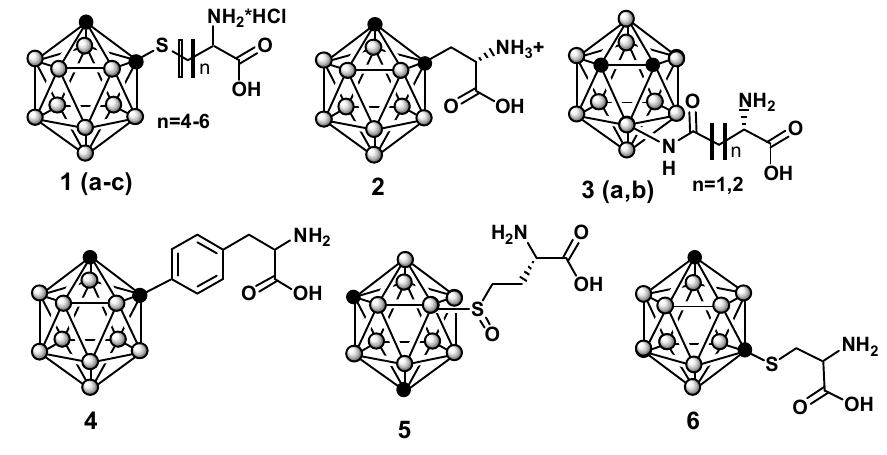
Figure 1. o- and m- carborane–amino acid conjugates.